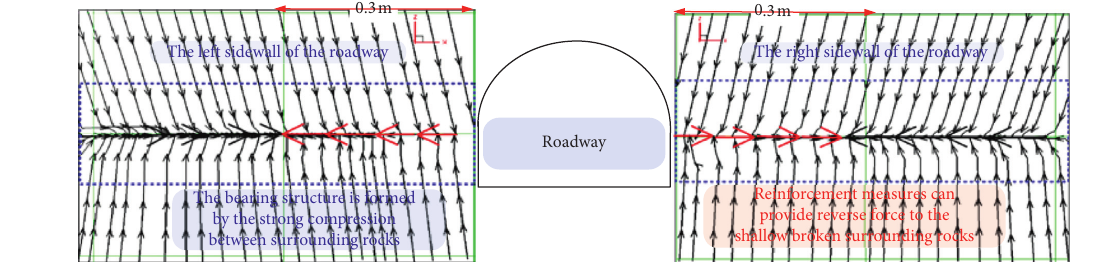
Figure 15: Partial enlarged view of surrounding rock stress path vector.